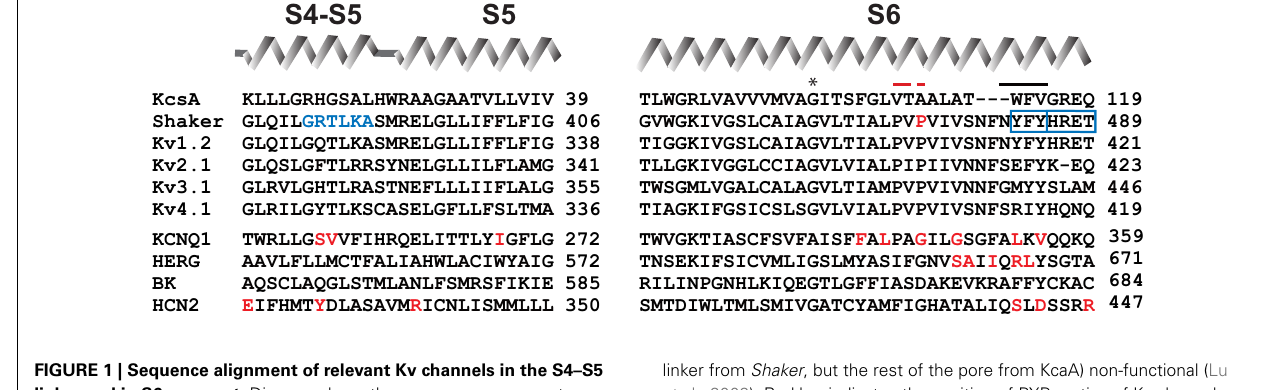
FIGURE 1 | Sequence alignment of relevant Kv channels in the S4–S5 linker and in S6 segment. Diagram above the sequences represents secondary structure elements corresponding to the recent crystal structure of Kv1.2–Kv2.1 chimeric channel in lipid-like environment (Long et al., 2007). Residues indicated by red letters show localization of the mutations involved in constitutive conductance of corresponding channels. Residues shown with blue letters and blue frames indicate position of mutations, which render Shaker- KcsA chimeras (carrying distal S6 starting from I477, as well as S4–S5